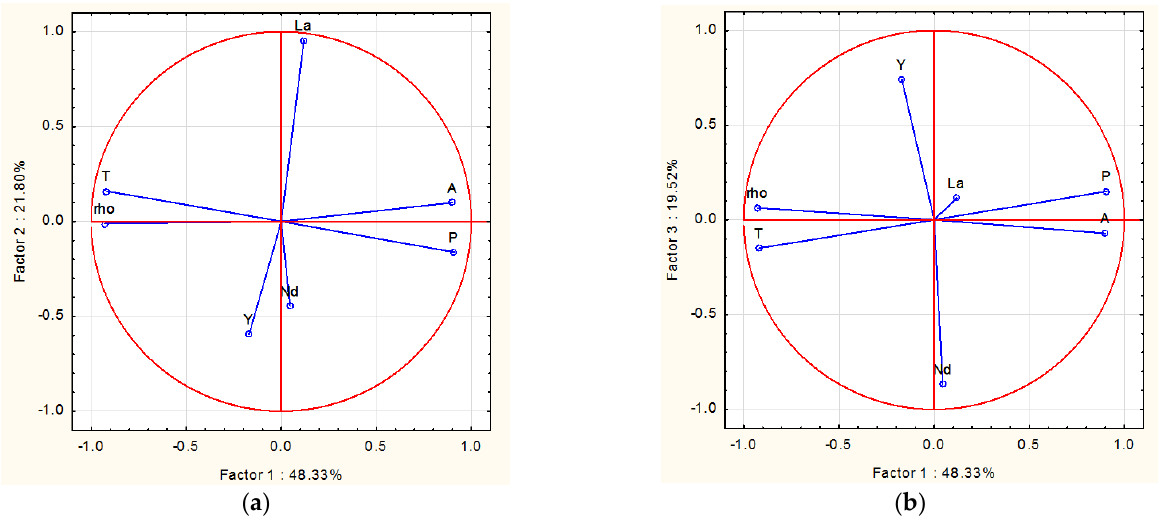
Figure 2. Projection of the variables on ( a ) PC1 and PC2 plane; ( b ) PC1 and PC3 plane. The first three PCs strongly explain the data variability: 48.33 + 21.80 + 19.52 = 89.65%.